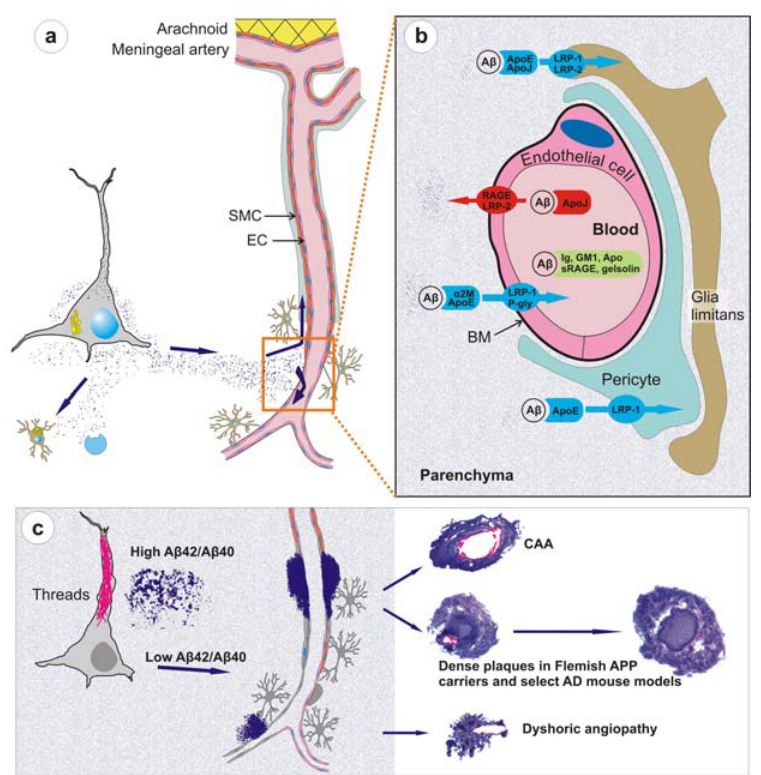
Figure 3. Physiological clearance and pathological deposition of A β in